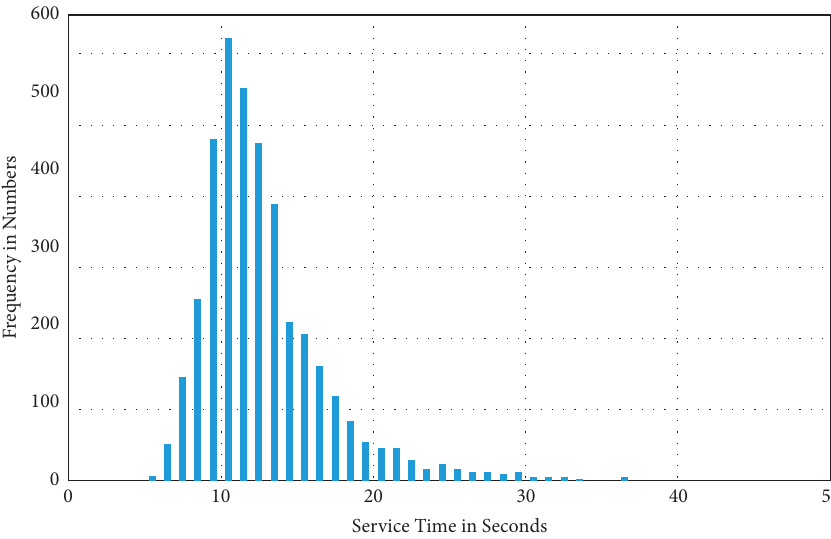
Figure 7: Frequent distribution of service time of lane 15# during the saturation period.